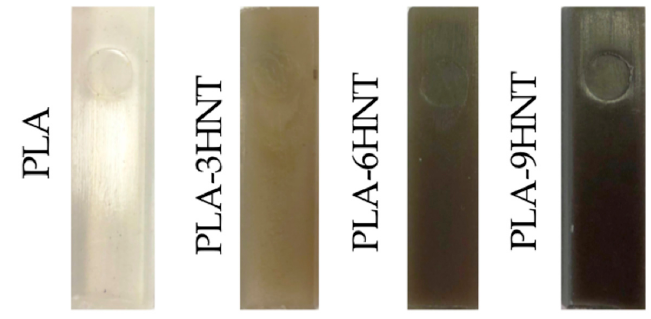
Figure 2. Digital images of PLA-HNT composites with different HNTs loading.